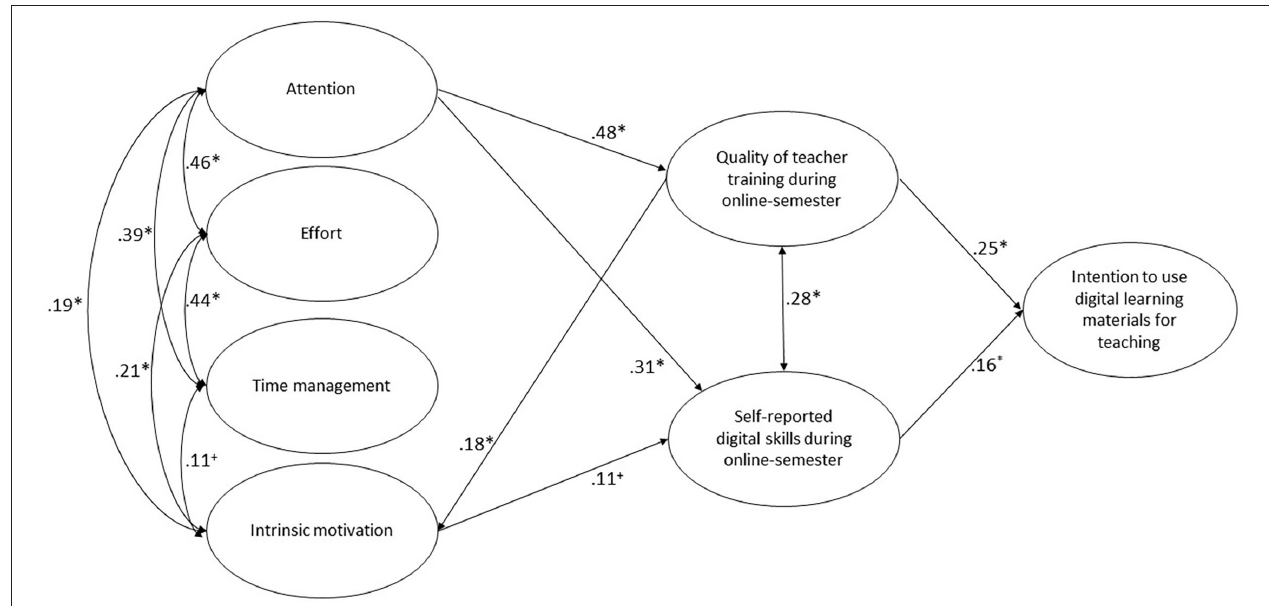
FIGURE 2 | Structural equation model. Only paths p < 0.10 are displayed. * p < 0.05; + p < 0.10. The included control variables study duration and school type are not illustrated. See Table 3 for the effects. See Table 4 for direct and indirect effects among